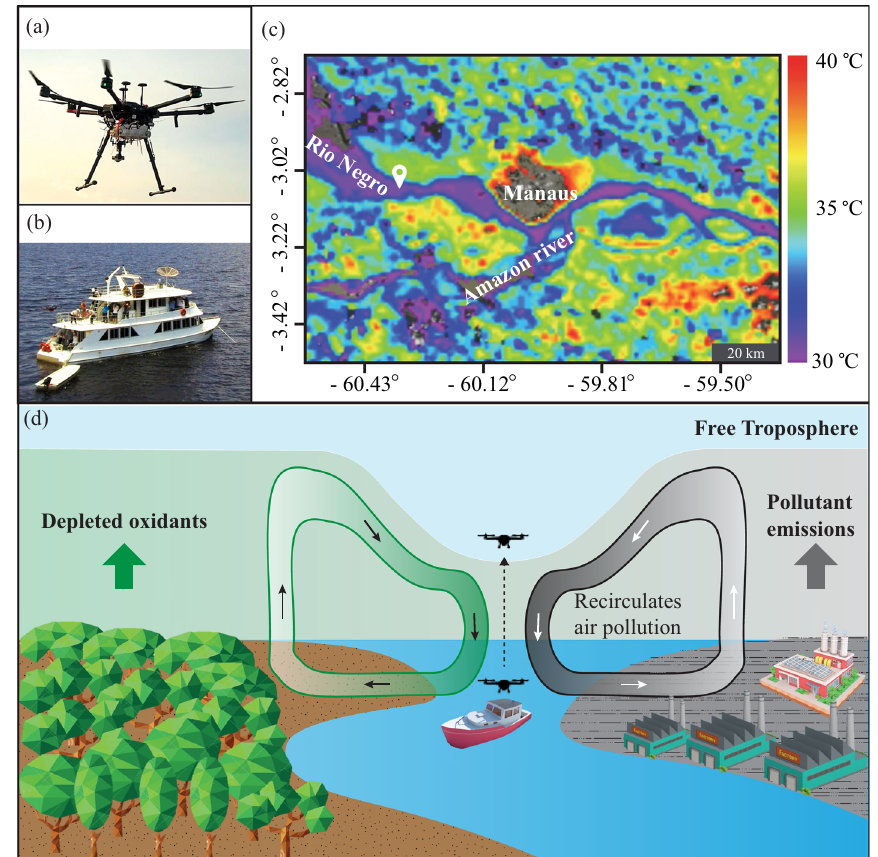
Fig. 1 Conceptual overview of river winds and details of fi eld campaign. a Photograph of the UAV. The sensor package was mounted to the UAV underside. b Photograph of the boat platform from which the UAV was launched and retrieved during the campaign. The boat was positioned at the white marker (3.0708° S, 60.3604° W) of panel ( c ). c Surface temperatures on a fair weather day 43 . The data for the false-color image were taken by the Aqua satellite at 13:30 (LT) over Manaus, Brazil, in the central Amazon on 26 September 2019. Satellite image credit: NASA ’ s Earth Observatory. d Representation of thermally driven recirculatory fl ow of river winds and reduced rates of pollutant dispersion in a river-forest landscape.